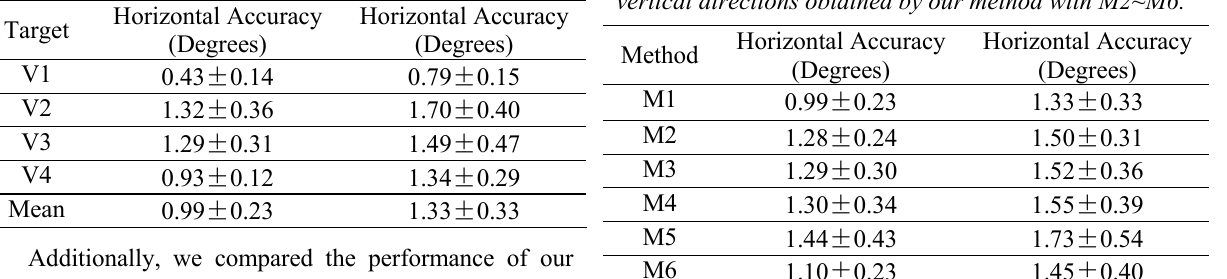
V V V V 1 2 3 4